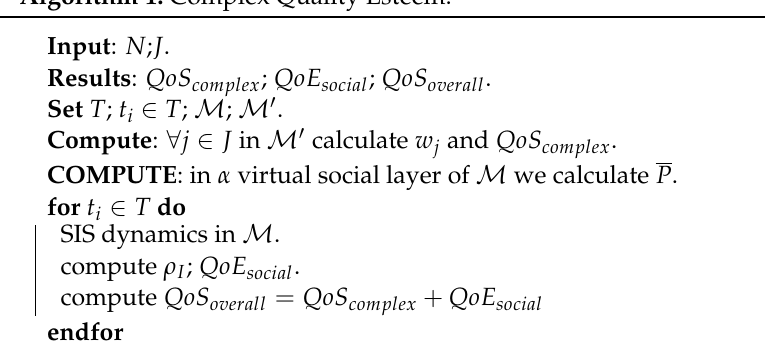
Algorithm 1: Complex Quality